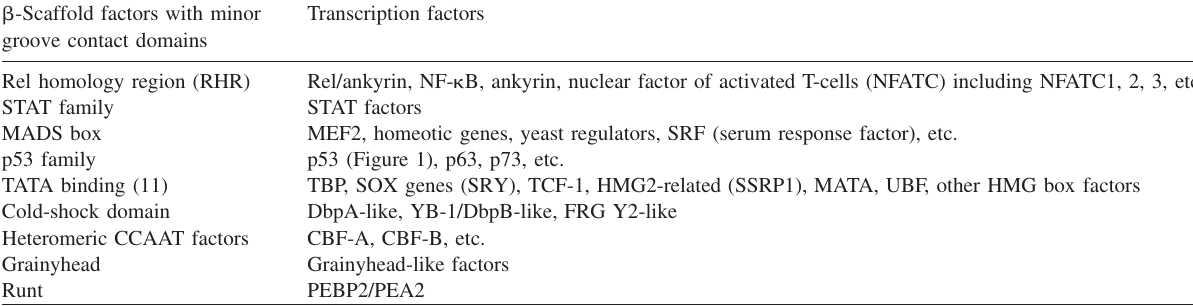
Table 4 Transcription b -scaffold factors with minor groove contact domains.